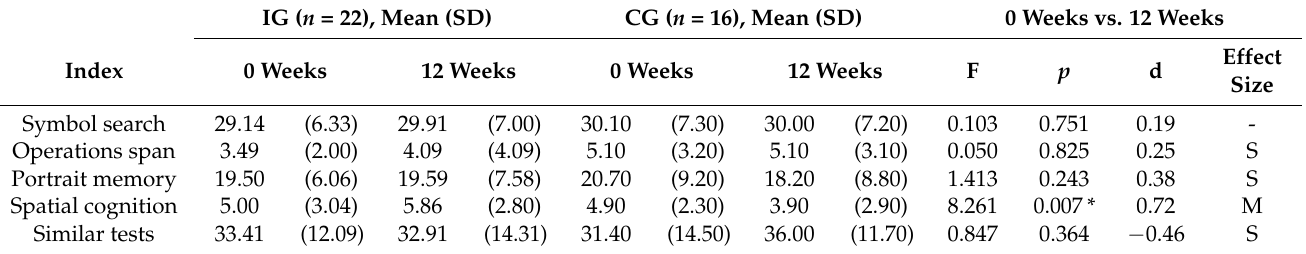
Table 3. Changes from baseline (0 weeks) to posttest (12 weeks) in the cognitive function